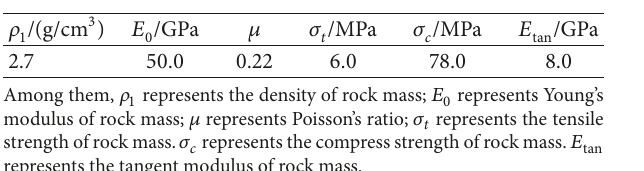
on front and back planes; the crustal stress is exerted on left plane; the symmetry constraints are exerted on right plane; the nonreflecting boundary and constraints are exerted on upper plane and the bottom is free surface. The two smooth blasting holes on left plane are grooved blast holes and the two on the right plane are circular blast